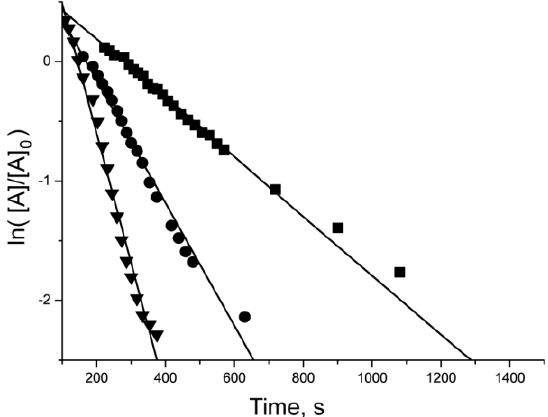
Figure 4. Kinetics of CIDNP on alkoxyamine 1a during thermolysis of 0.02 M solution of alkoxyamine in FSol in the presence of thiophenol and its fit (line) with monoexponent in semi-logarithmic scale: 361 K, [PhSH] = 0.1 M (■), 373 K, [PhSH] = 0.136 M (●), 398 K, [PhSH] = 0.13 M (▼). The values of k obtained from the fit: 361 K— k = 2.0 × 10 −3 s −1 obs obs